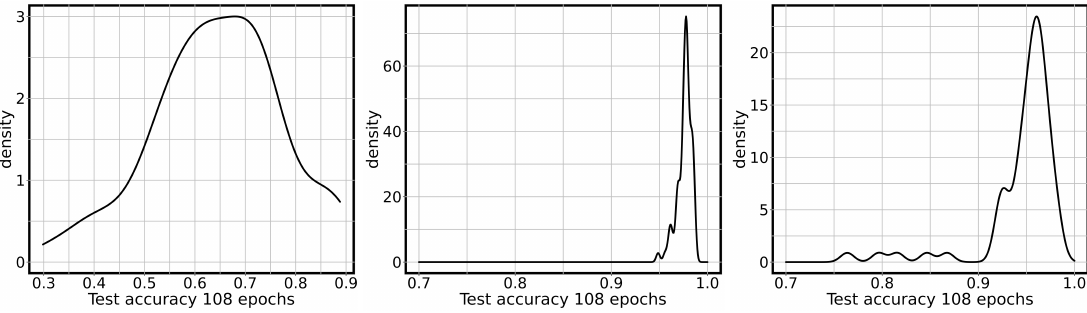
Figure 4. PDF of fitness after 108 epochs of training. From left to right are results using Sentinel-1, Sentinel-2 and both sensors as input.